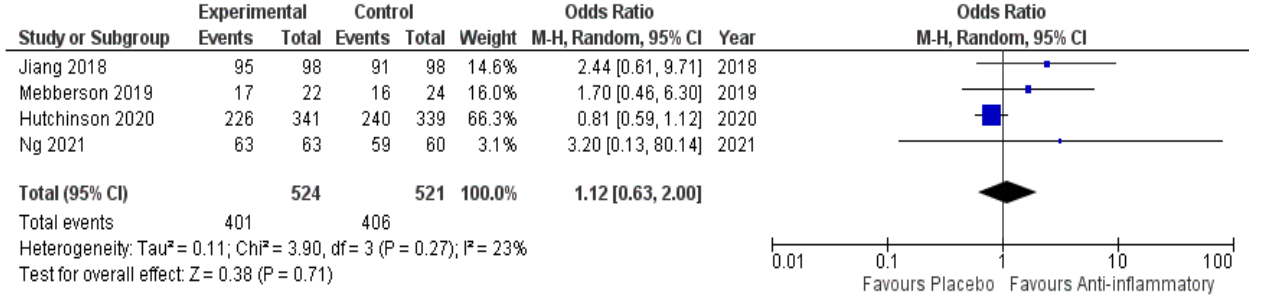
Figure 4. Forest Plots displaying OR and 95% CI estimates for favorable neurological outcome in studies [28–31] evaluating anti-inflammatory therapies compared to placebo in cSDH patients treated surgically or conservatively. Squares represent the odds ratio; the bigger the square, the greater the weight given because of the narrower 95% CI. Diamond represents the odds ratio of the overall data.